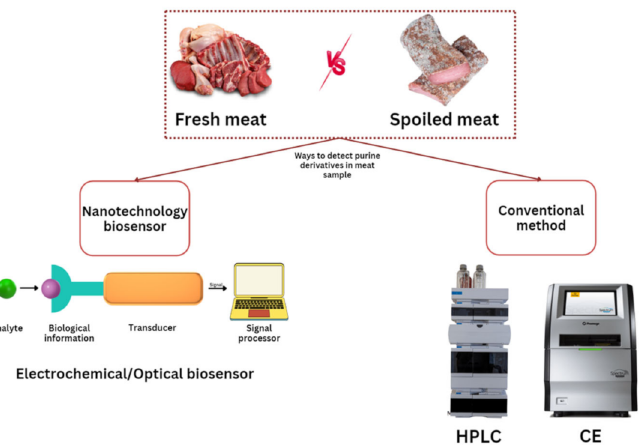
Figure 1. The available methods of biosensors for the detection of purine